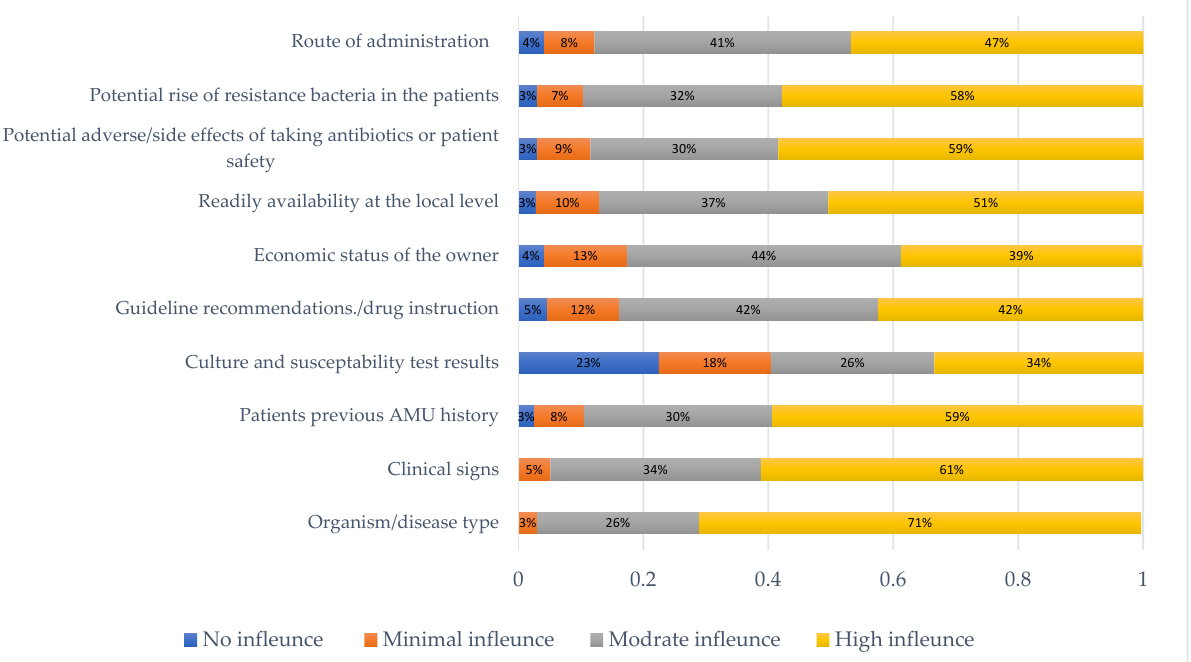
Figure 2. Clinical etiological and other factors influencing the selection of antimicrobial prescription or administration by the veterinarians.